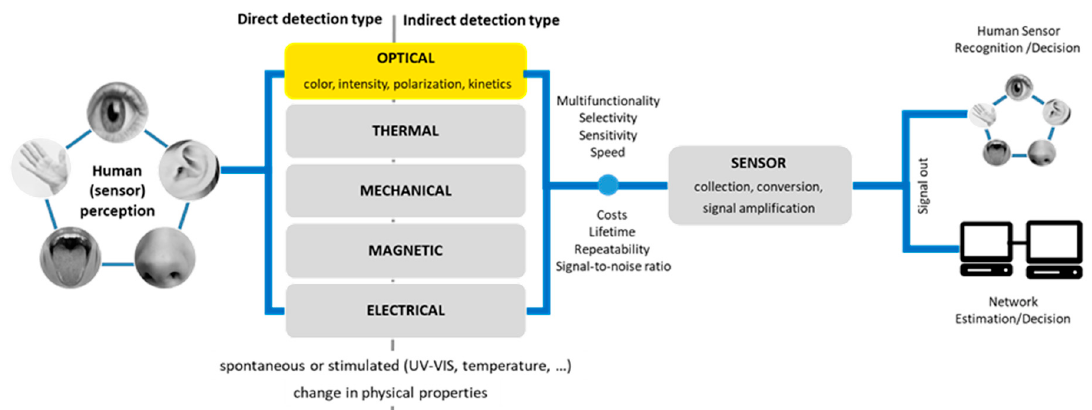
Figure 3. Signal processing characteristics for living organisms and sensor machines.